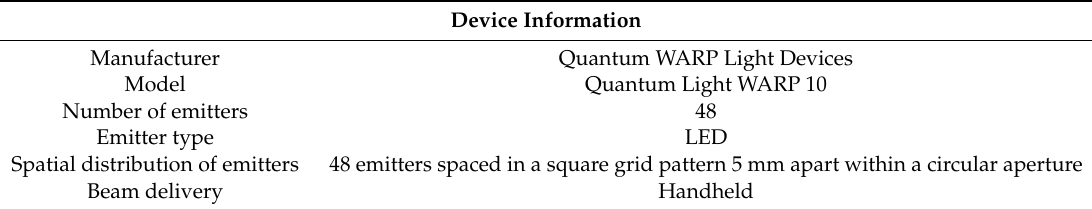
Table 1. A summary of the PBM device information.